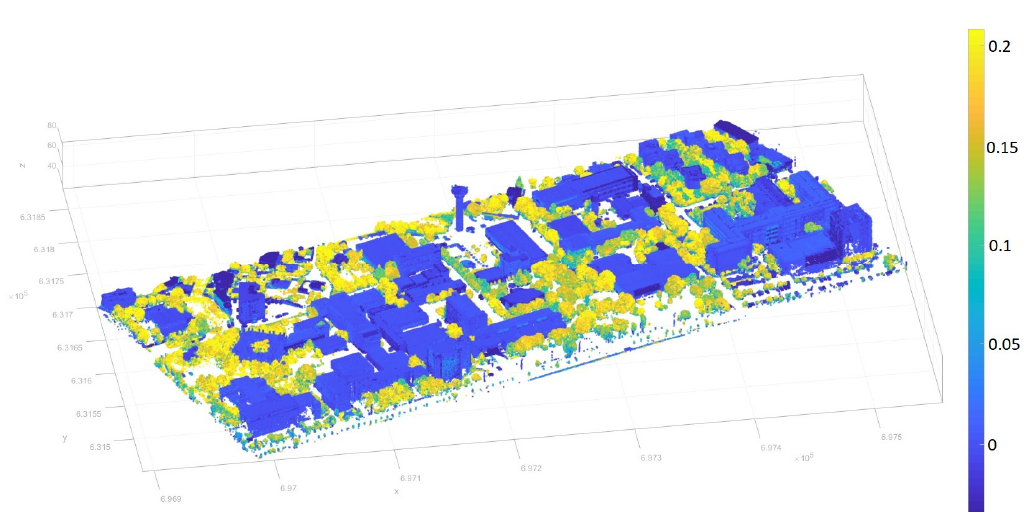
Figure 13. UAV point cloud colored based on the visible-band difference vegetation index (VDVI), blue color indicates values of 0 for the VDVI attribute.